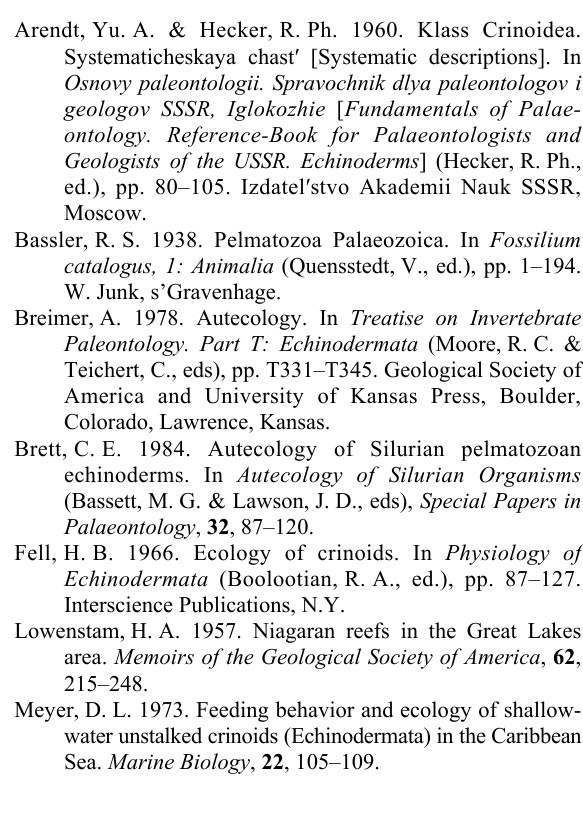
Fig. 4. Life position reconstruction of Elgaecrinus uralicus